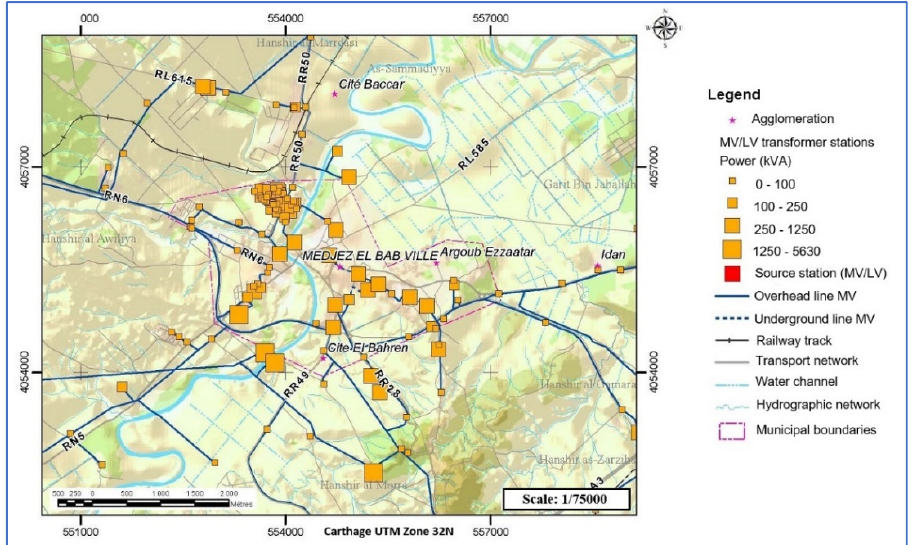
Figure 7. MV/LV transformer stations.